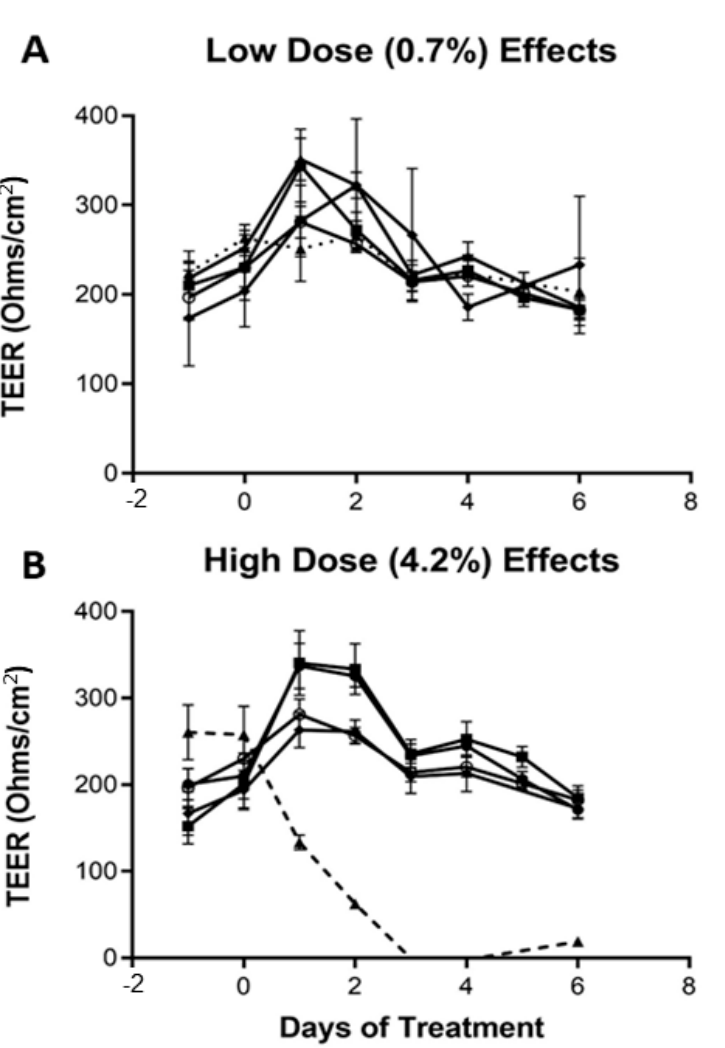
Figure 1. Effects of apical vegetable juices on trans-epithelial electrical resistance (TEER) of Caco- 2Bbe1 inserts above SH-SY5Y cells. Shown are seven consecutive daily TEER readings on the inserts of co-cultures fed on day-0 with the shown dilutions of either phosphate-buffered saline (PBS open circles, solid line), kale juice (closed squares, dashed line), dandelion juice (closed triangles, dashed line), spinach juice (open triangle, dotted line), or lettuce juice (closed diamonds, solid line). The readings began 15 days after seeding the Caco-2Bbe1 on inserts, minutes after the apical media had been switched to 1% FBS and the inserts had been transplanted above growing SH-SY5Y s in 0.5 mL complete media basolateral (Scheme 2). Twenty-four hours hence, day-0, the apical media was replenished to complete 10% FBS media plus either phosphate-buffered saline or the juices to final dilutions ( v / v ) of 0.7% (Panel A ) or 4.2% (Panel B ), not changing the basolateral media at any point, and TEER readings continued. Values represent the mean ± SEM ( n = 4–6 experiments per condition). Asterisks indicate statistical significance by two-way ANOVA, multiple comparisons: kale-high vs. saline ( p = 0.065 at 1 day, p = 0.019 at 2 days), dandelion-high vs. saline ( p = 0.048 at 1 day, p = 0.008 at 2 days).